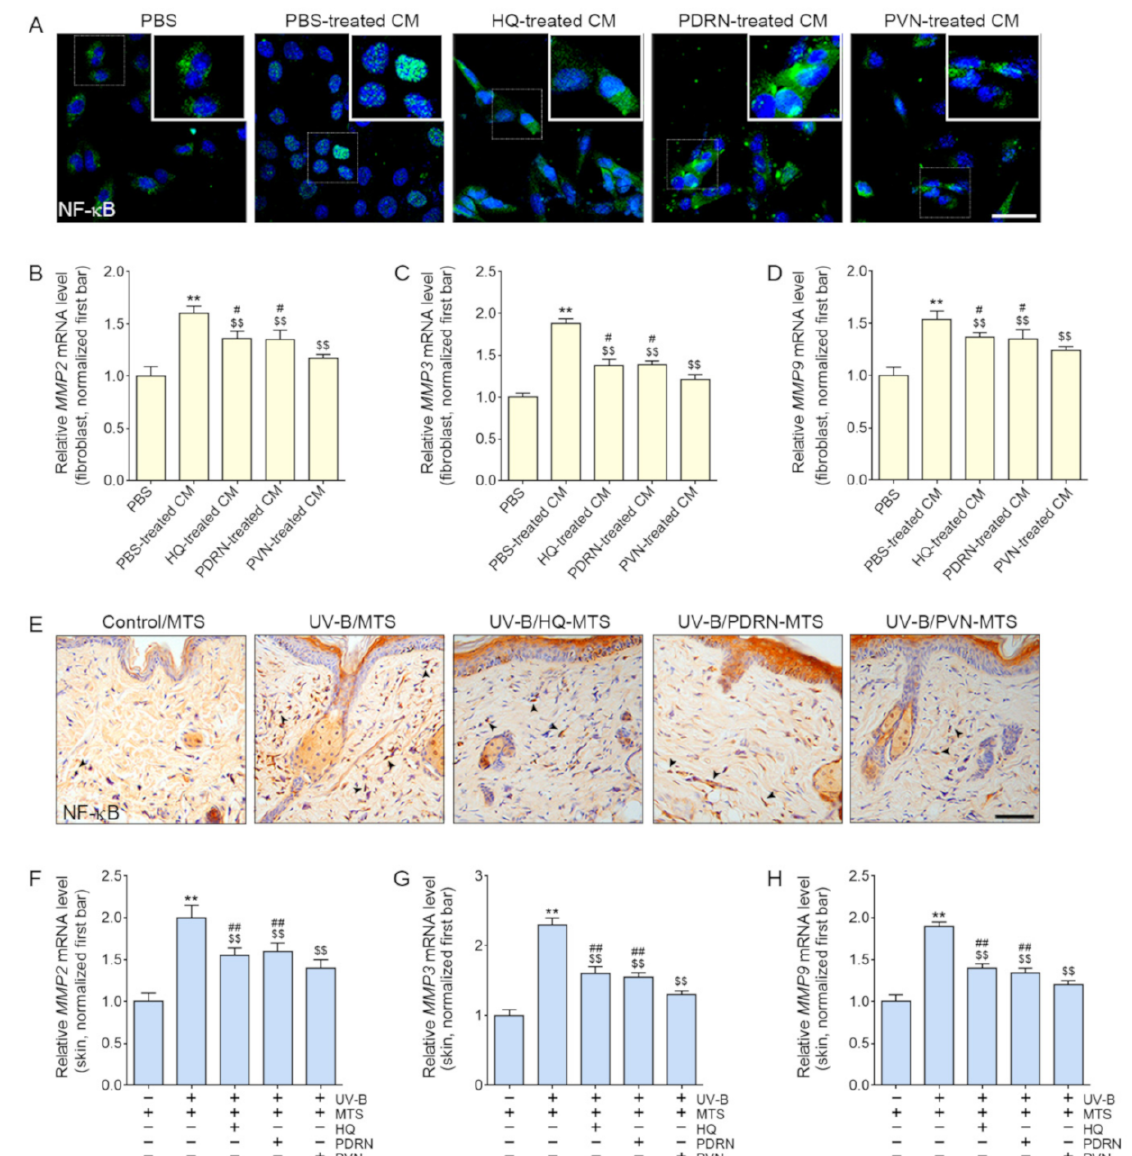
Figure 3. Regulation of NF- κ B and MMP2/3/9 expression by HQ, PDRN, and PVN treatment. ( A ) The NF- κ B expression in the fibroblast treated with PBS or CM from UV-B-radiated keratinocytes was determined by immunofluorescence staining (scale bar = 50 µ m). CM was obtained from UV-B- radiated keratinocyte culture treated with HQ, PDRN, or PVN. ( B – D ) The mRNA expression levels of MMP2/3/9 determined in the fibroblast treated with PBS or CM from UV-B-radiated keratinocytes. The mRNA levels were normalized by Actb and expressed relative to the levels in the PBS group. ( E ) The NF- κ B expression in the UV-B-radiated animal skin was determined by immunohistochem- istry (scale bar = 100 µ m). The arrows indicated positive NF- κ B expression in the nuclei. ( F – H ) The mRNA expression levels of MMP2/3/9 determined in the UV-B-radiated animal skin. The mRNA levels were normalized by Actb and expressed relative to the levels in the control group. Data are presented as the mean ± standard deviation: **, p < 0.01 vs. first bar; $$, p < 0.01 vs. second bar; #, p < 0.05 and ##, p < 0.01 vs . 5th bar (Mann–Whitney U test). CM, conditioned medium; HQ, hydroquinone; MMP, matrix metalloproteinase; MTS, microneedling therapy system; NF- κ B, nuclear factor kappa-light-chain-enhancer of activated B cells; PBS, phosphate-buffered saline; PDRN, [oly- deoxyribonucleotide; PVN, polydeoxyribonucleotide+vitamin C+niacinamide; UV-B, ultraviolet